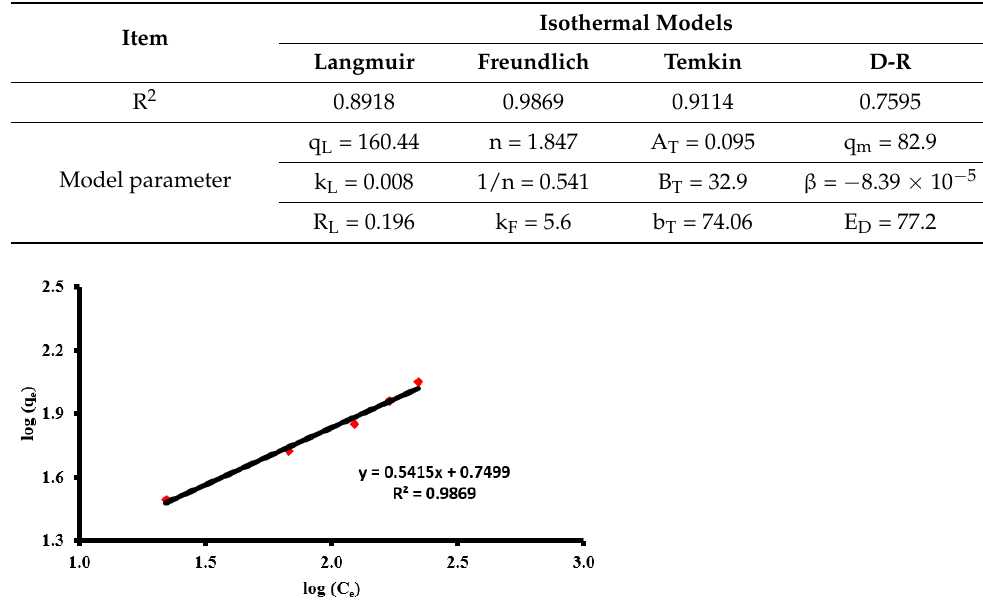
Figure 4. Freundlich isotherm model of the adsorption of AZM via